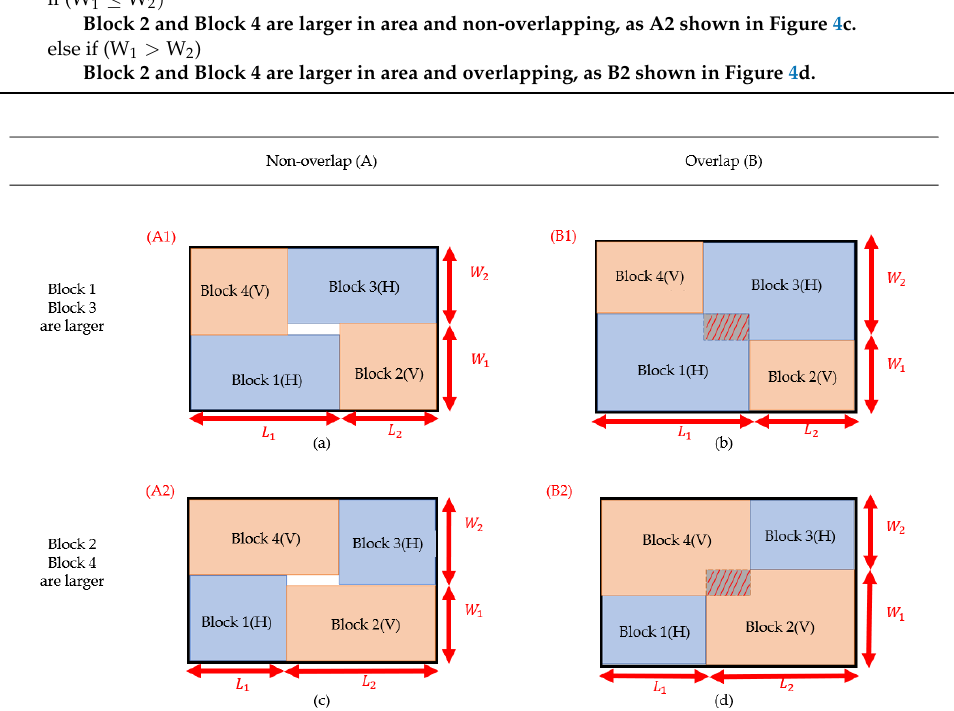
Figure 5. Horizontal multi-object overlap.